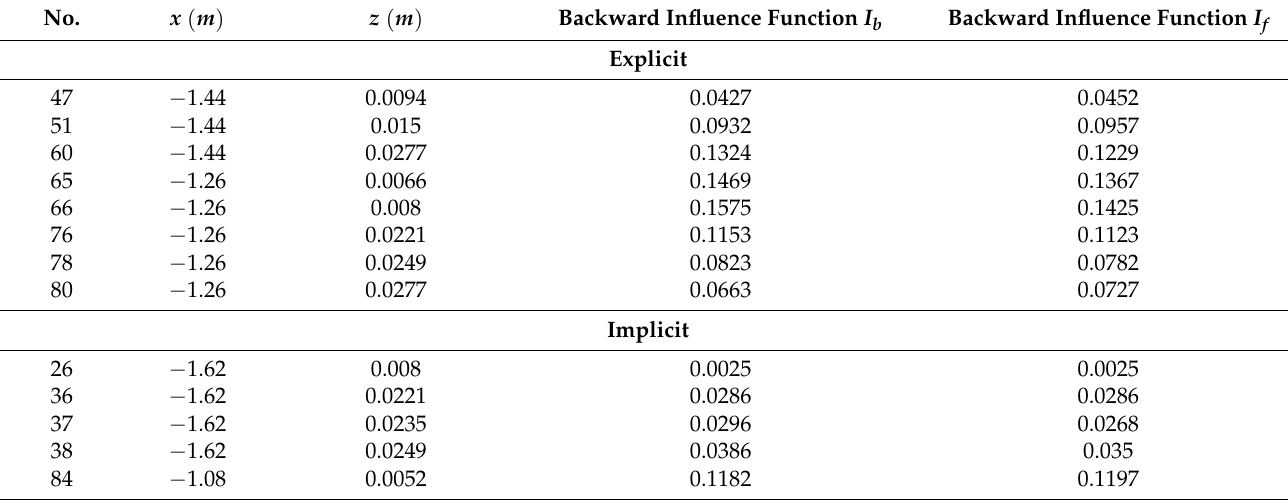
Table 2. The most probable sources selected out when the threshold is 0.1 and their corresponding influence functions.